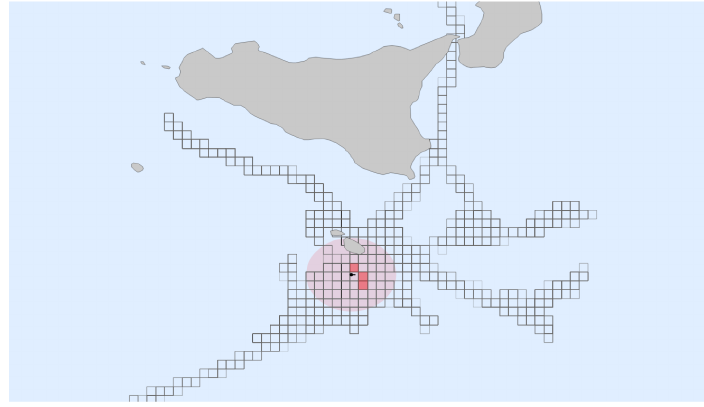
Figure 12. A snapshot of a map from the web